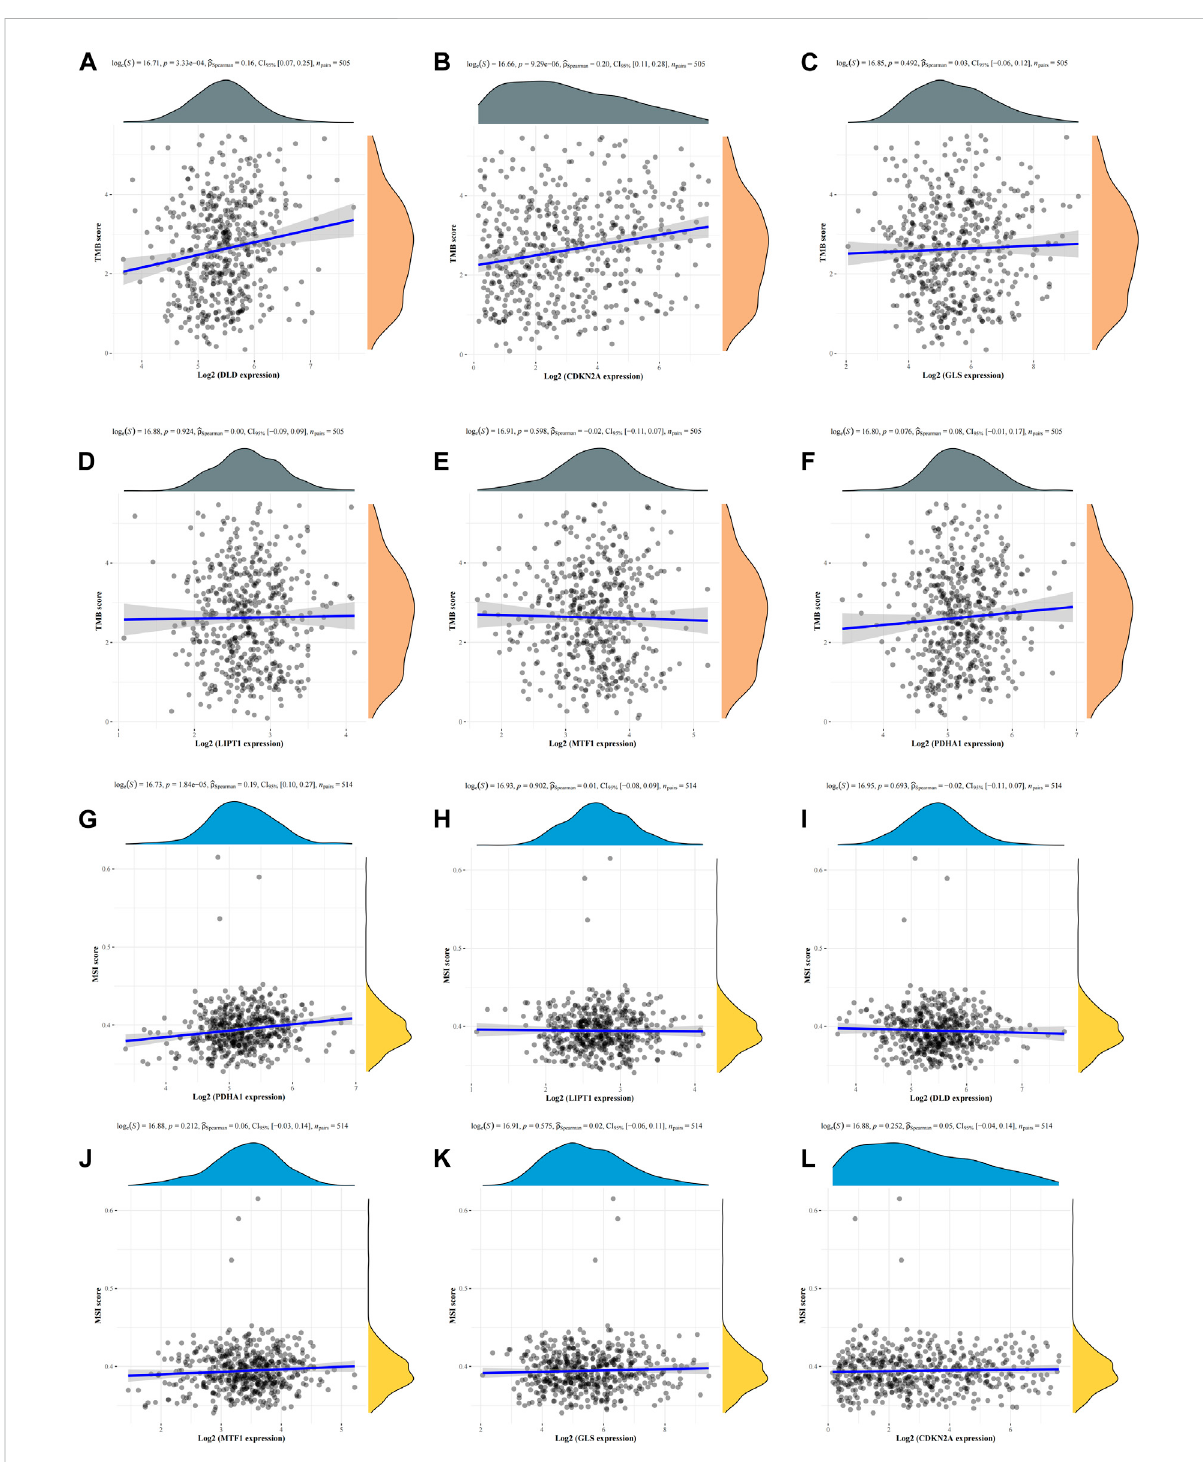
FIGURE 7 Correlation analysis of the six CRGs with TMB and MSI in LUAD. (A – F) Correlation between the six CRGs and TMB in LUAD. (G – L) Correlation between the six CRGs and MSI in